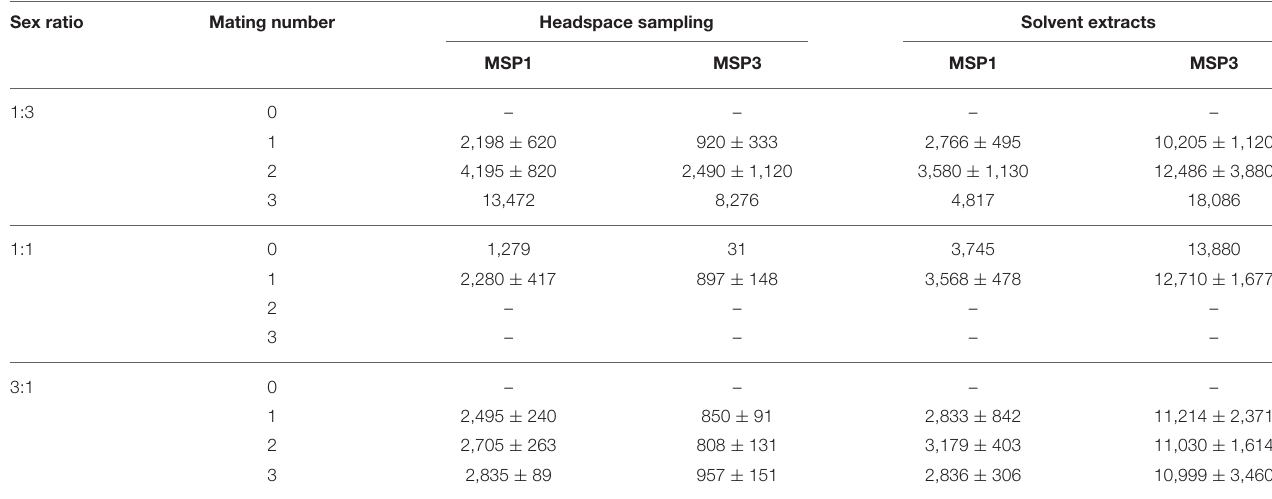
TABLE 1 | Mean MSP1 and MSP3 amounts in ng/individual ( ± 1SE, where applicable) for headspace samples and solvent extracts for each sex ratio and mating number. Sex ratio Mating number Headspace sampling Solvent extracts MSP1 MSP3 MSP1